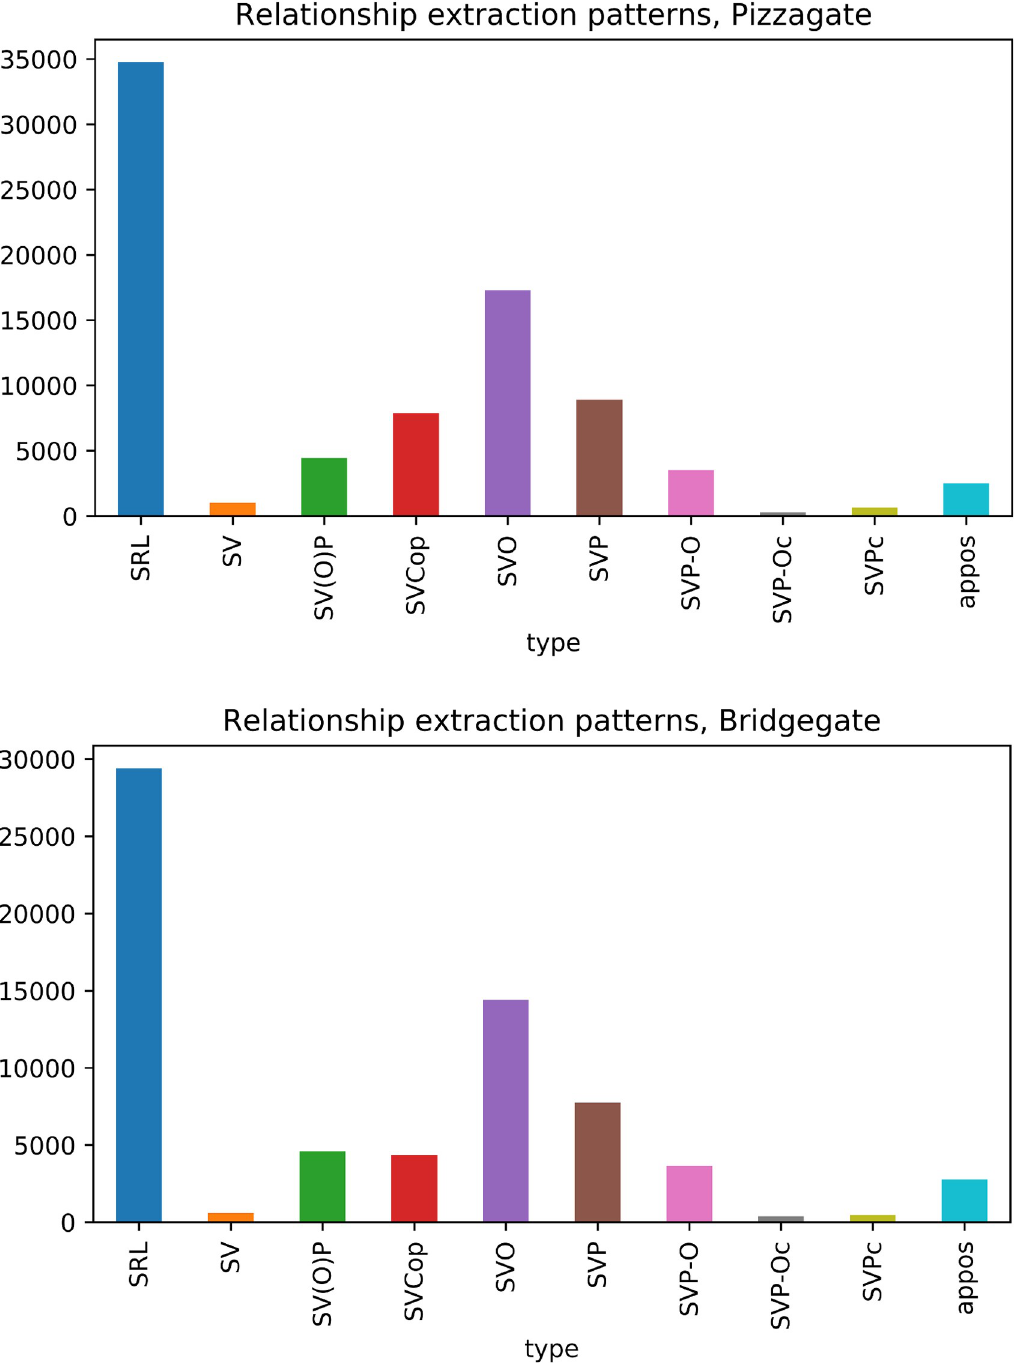
Fig 5. Relationship extraction patterns. Patterns by total number for A: Pizzagate (top) and for B: Bridgegate (bottom). For example, SVO is (nsubj, verb, obj), SRL is (A0, Verb, A1) and (A0, Verb, A2). A larger list can be found in S1 File.